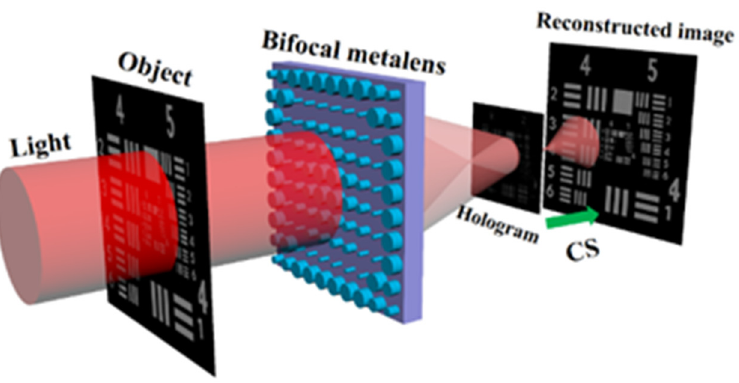
Figure 14. Schematic of coaxial holography and compress sensing reconstruction based on bifocal metalens [37]. Copyright (2020) Optical Society of America.